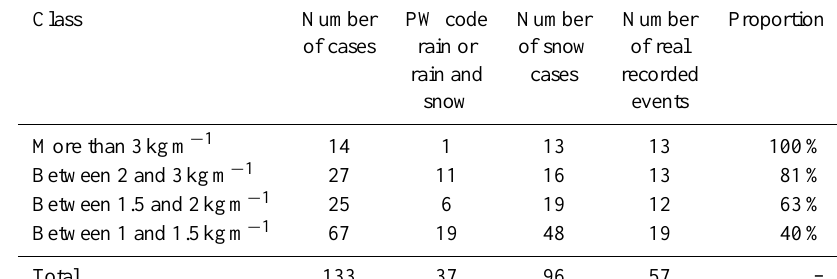
Table 2. Study of the 133 cases of calculated loads greater than 1kgm − 1 . PW: present weather.